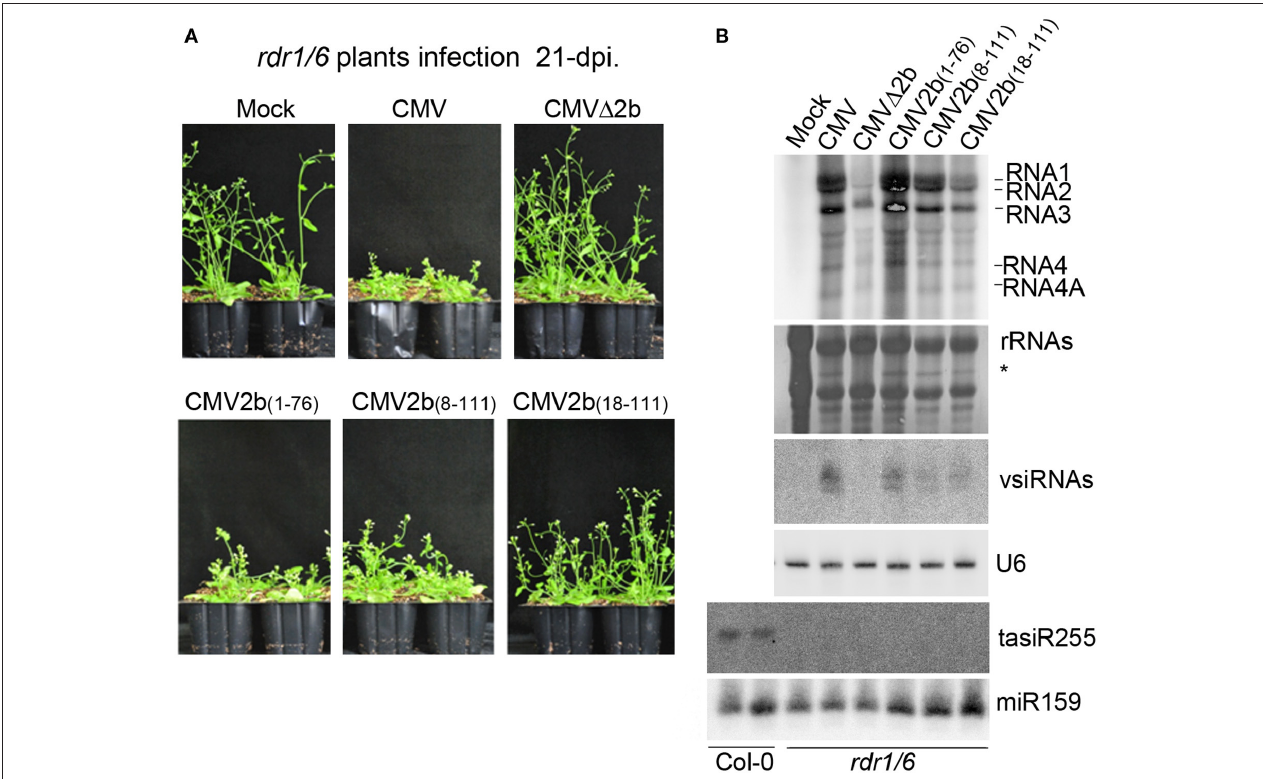
FIGURE 5 | Effects of 2b and its mutants on the virulence and accumulation of viral RNAs in infection of rdr1/6 plants. (A) Disease symptoms in rdr1/6 plants inoculated with CMV and CMV2b ( x ) at 21 dpi. (B) RNA gel blot detection of viral genomic RNAs and vsiRNAs. tasiR255 was used to verify the RDR mutant alleles. Methylene blue-stained ribosome rRNA and U6 as well as miR159 were used as the loading